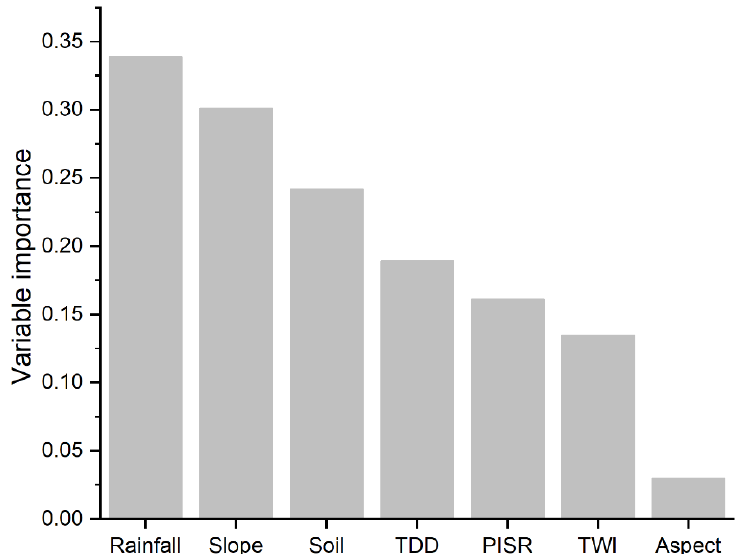
Figure 7. The relative importance of each environmental variable (i.e., soil, rainfall, TDD, TWI, PISR, aspect, and slope) for TLs.